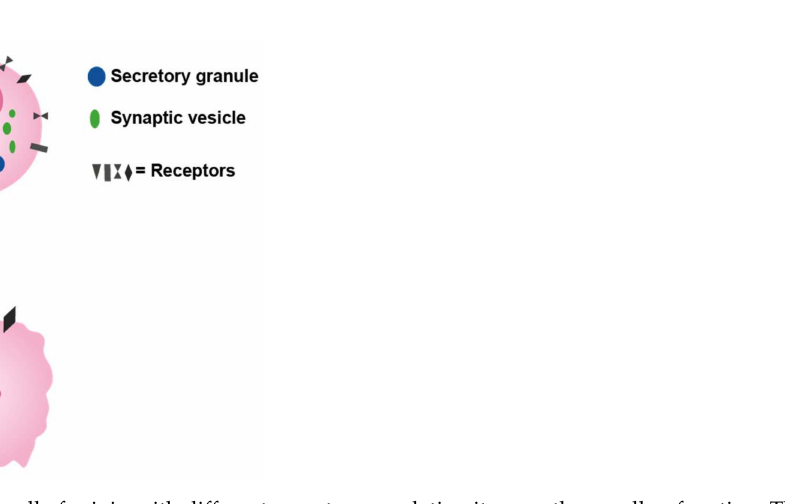
Figure 2. The cell of origin with different receptors regulating its growth as well as function. This cell is depicted as a neuroendocrine cell with secretory granules (upper cell). A malignant cell developed from this cell (lower cell) has lost most of the specific traits like typical secretory granules which nevertheless may be identified as that by immuno-electron microscopy. Moreover, the number of receptors is reduced, but some receptors are maintained giving rise to possible treatment